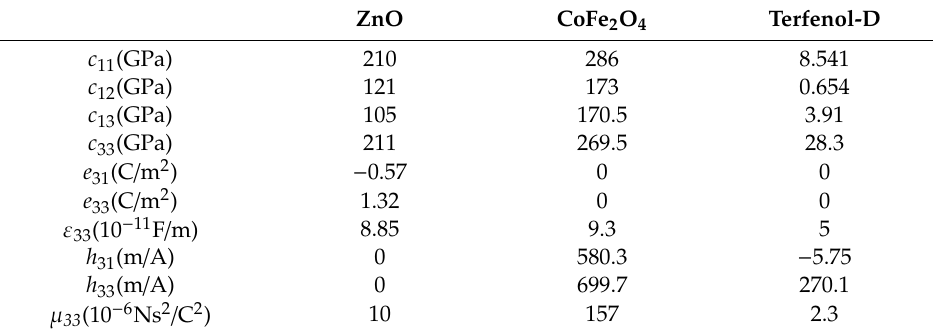
Table 1. Material properties of ZnO [50], CoFe 2 O 4 [51], and Terfenol-D